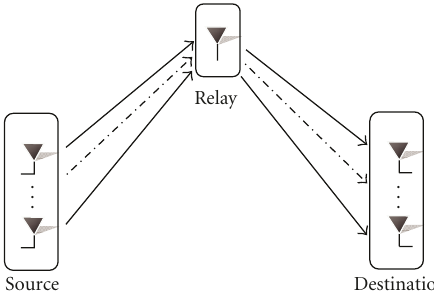
Figure 1: Two-hop relay system